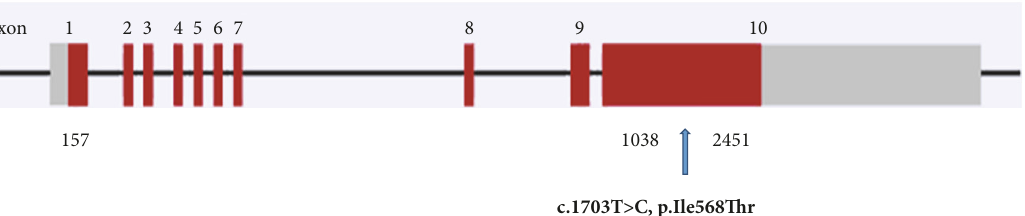
Figure 3: Schematic representation of TSHR containing 10 exons (numbered 1-10 in red) with the introns represented by the horizontal line joining the exons. The grey region represents the untranslated region (UTR). The position of the variant at the position 1703 is shown in exon